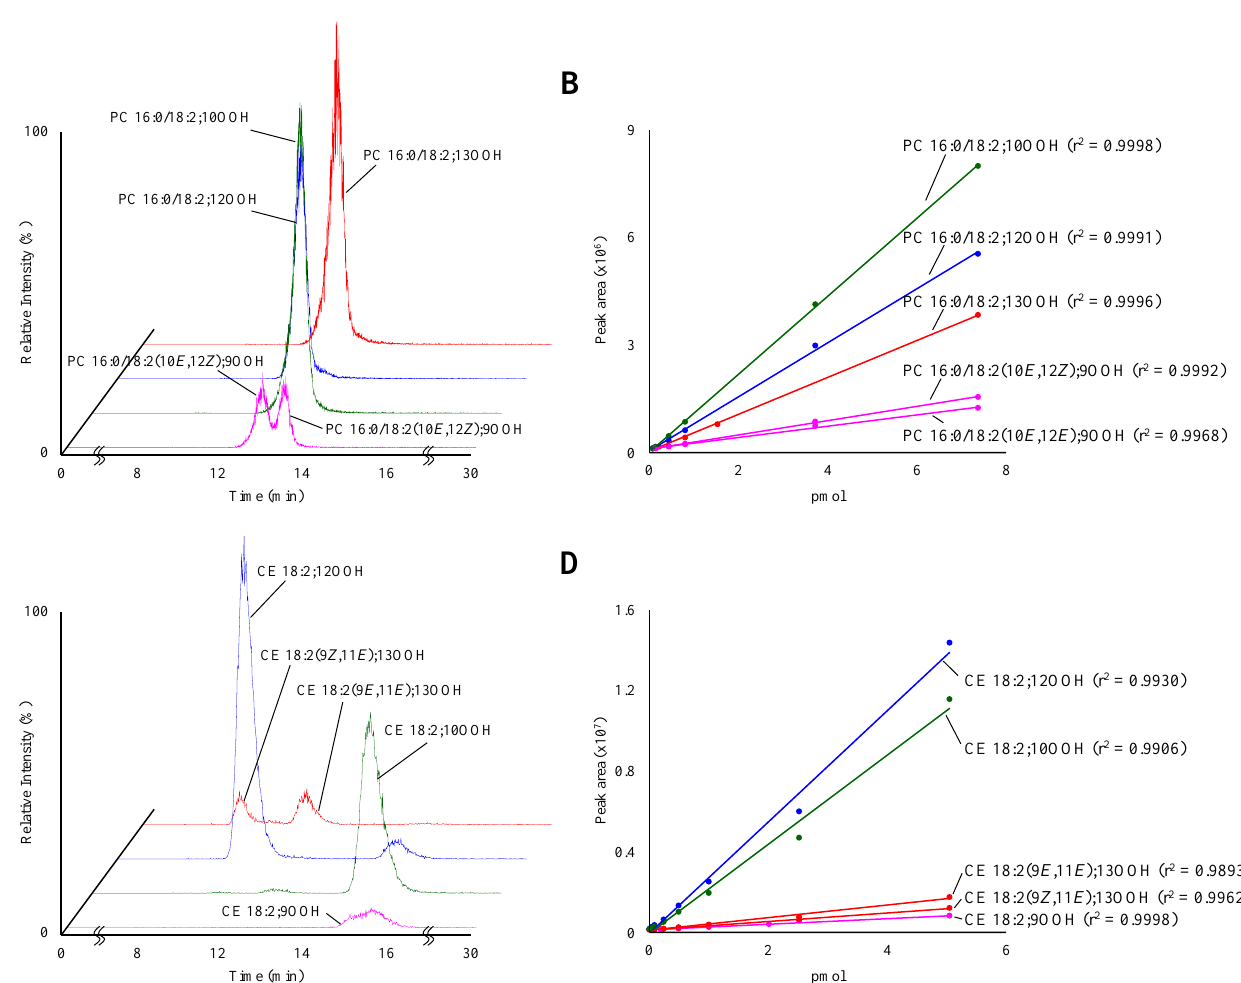
Figure 3. MRM chromatograms of reference PC 16:0/18:2;OOH isomers ( A ) and CE 18:2;OOH isomers ( C ). The references (0.5 pmol each) were analyzed with MRM ( m/z 813 > 388 for PC 16:0/18:2(10 E ,12 Z );9OOH and PC 16:0/18:2(10 E ,12 E